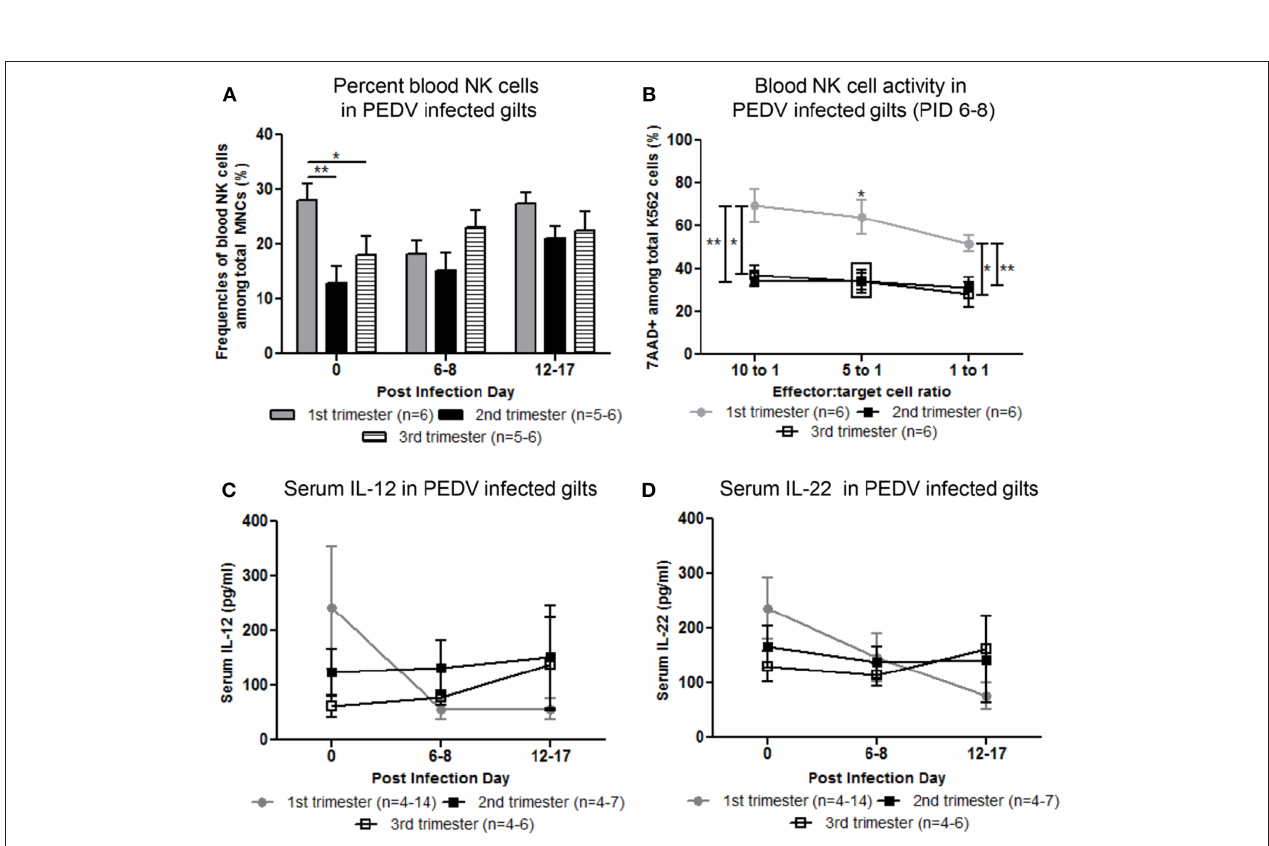
FIGURE 3 | Peripheral natural killer (NK) cell frequency and function and serum interleukin (IL)-12 and IL-22 concentrations were increased in first compared with second and third trimester gilts. (A) Peripheral blood mononuclear cells (PBMCs) were isolated and NK cell (CD3 − , CD172 − , CD8 + ) frequencies were determined by flow cytometry at post infection day (PID) 0, 6–8, and 12–17. (B) PBMCs and CFSE-stained K562 tumor cells were used as effector and target cells, respectively, and co-cultured at 10:1 5:1 and 1:1 ratios to assess NK cell cytotoxic function at PID 6–8. (C) Serum cytokine concentrations (pg/ml) of IL-12 and (D) IL-22 were measured at PID 0, 6–8, and 12–17. Asterisks indicate significant differences among treatment groups (mean ± SEM). Statistical analysis was performed using the Student’s t -test (B) or two-way ANOVA with repeated measures and Bonferroni’s correction for multiple comparisons (A,C,D) . * P < 0.05, ** P < 0.01.